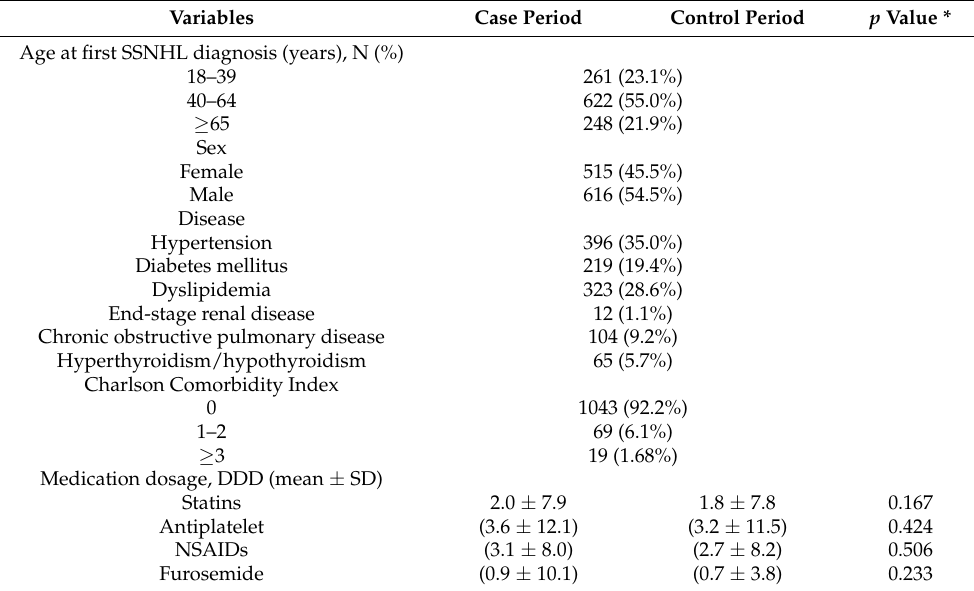
Table 1. Characteristics of Case-Crossover Patients with SSNHL Having and Not Having Acute URI Exposure (1-Month Period as the Exposure Time